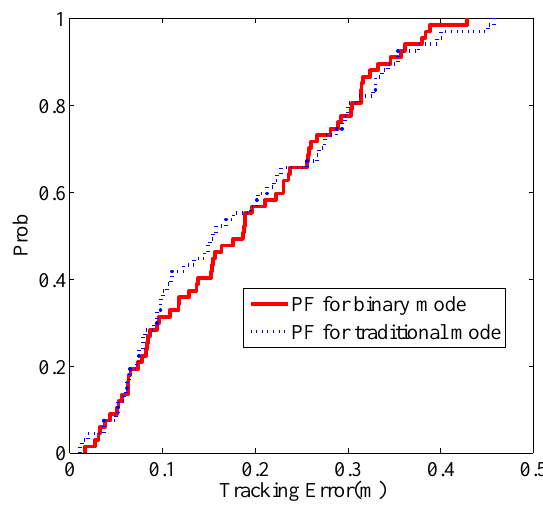
Figure 18. CDF of localization